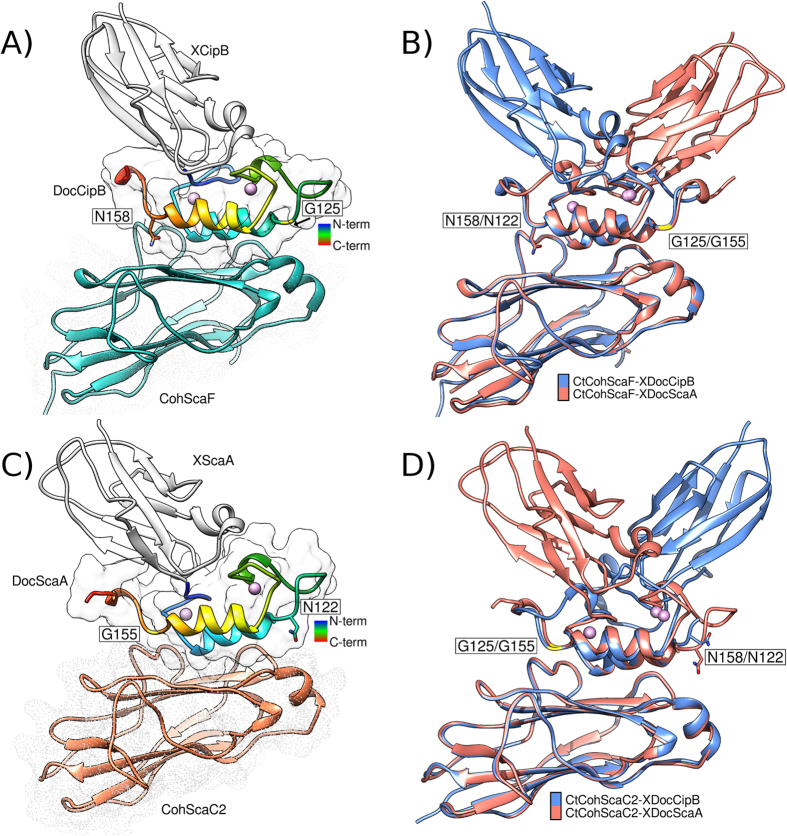
The structures of C. thermocellum CtCohScaF-XDocCipB and CtCohScaC2-XDocScaA complexes.The structures of CtCohScaF-XDocCipB (Panel A) and CtCohScaC2-XDocScaA (Panel C) complexes were solved, illustrated using the same design described in Fig. 2. The structures of CtCohScaF-XDocCipB and CtCohScaF-XDocScaA complexes (Panel B) and of CtCohScaC2-XDocScaA and CtCohScaC2-XDocCipB complexes were overlaid (Panel D).